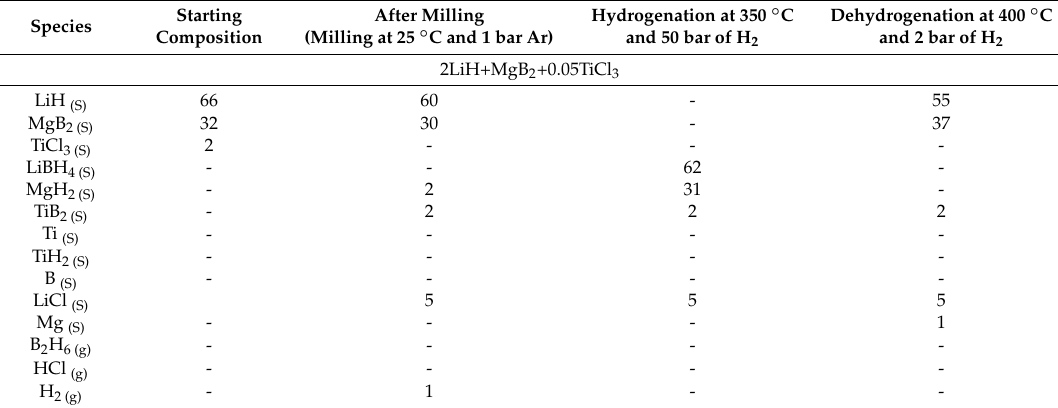
Table 1. Phase equilibrium compositions (mol %) for 2LiH+MgB 2 +0.05TiCl 3 . Conditions: 25 ◦ C under 1 bar of Ar for MM, 350 ◦ C under 50 bar of H 2 for hydrogenation, and 400 ◦ C under 2 bar of H 2 for dehydrogenation (same conditions used for the cycling in Figure